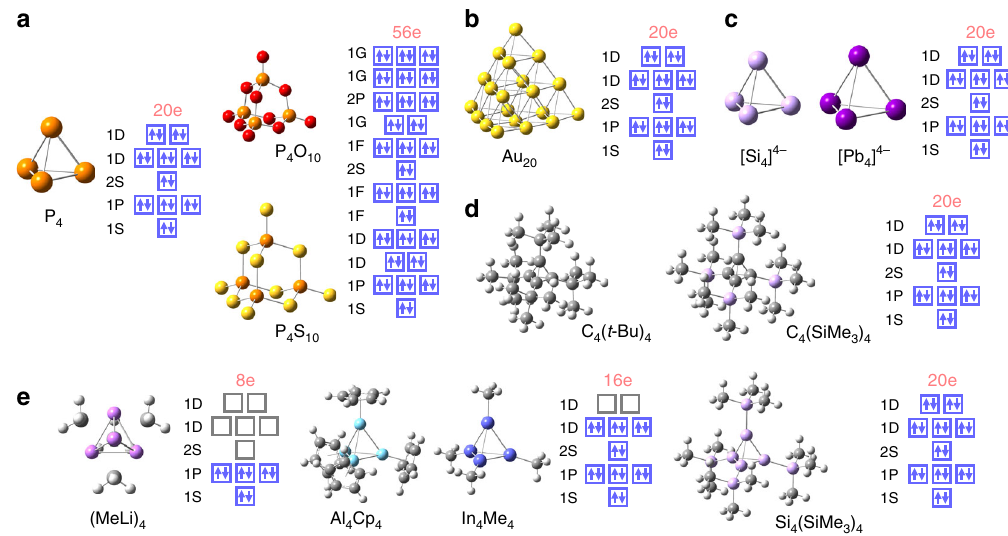
Fig. 7 Electronic con fi gurations of real compounds. a Natural products (P 4 , P 4 O 10 , and P 4 S 10 ). b The magic gold cluster (Au 20 ). c Zintl anions ([Si 4 ] 4 − and [Pb 4 ] 4 − ). d Organic compounds (C 4 ( t -Bu) 4 and C 4 (SiMe 3 ) 4 ). e Organometallic clusters ((MeLi) 4 , Al 4 Cp 4 , In 4 Me 4 , and Si 4 (SiMe 3 ) 4